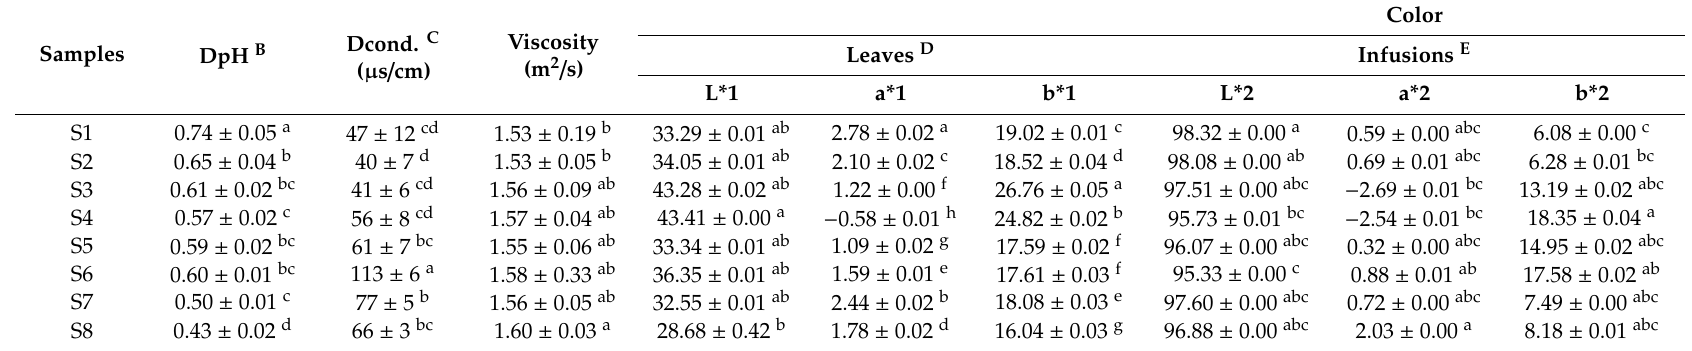
Table 1. The physicochemical properties analysis of Nü-Er-Cha A